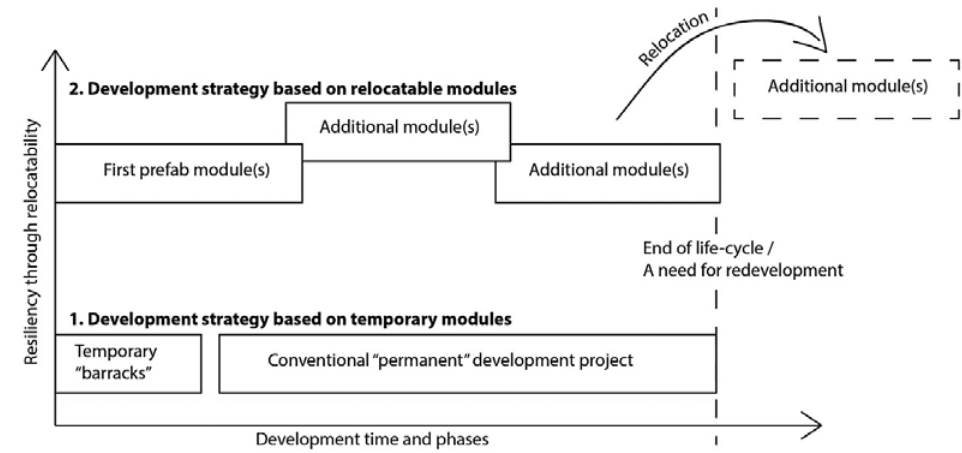
fig. 1. development strategies of education facilities from a life-cycle